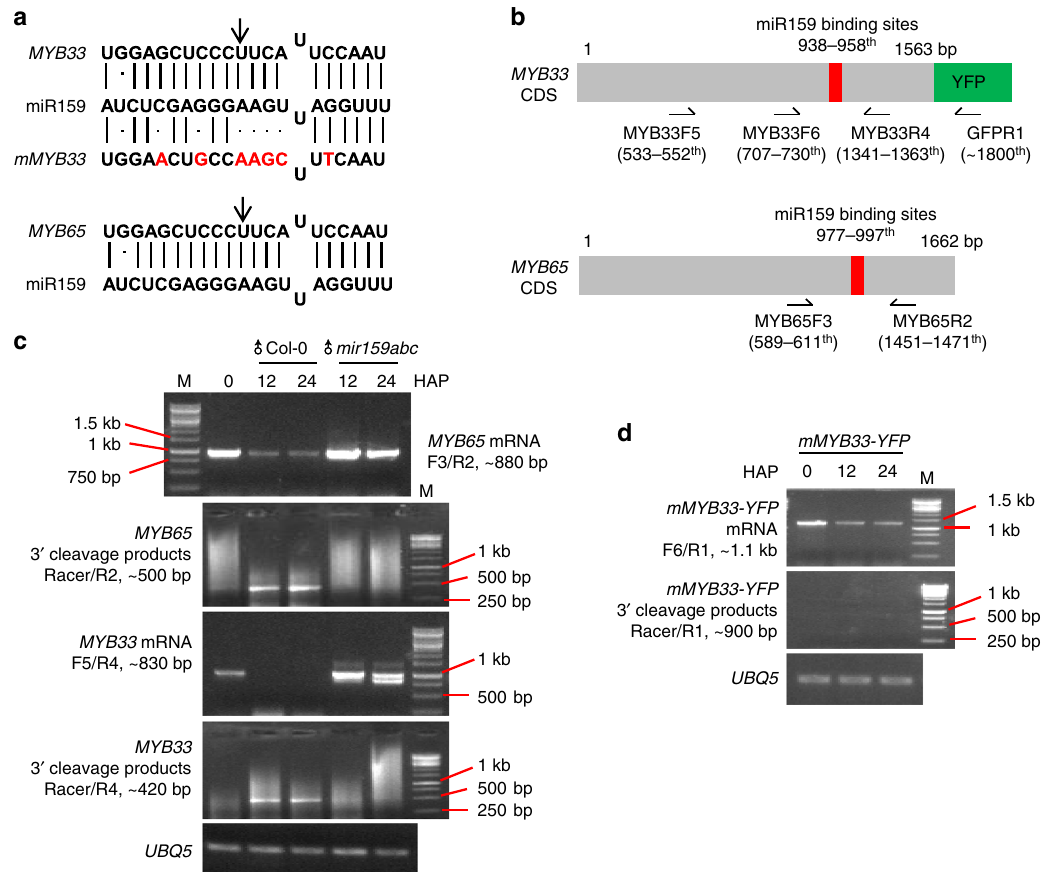
Fig. 4 Detection of 3 ′ cleavage products of MYB33 and MYB65 by 5 ′ RACE-PCR. a Alignment of miR159 and its targeting sites on MYB33 and MYB65 . Mutated nucleotides of miR159 binding sites are highlighted in red as mMYB33 . Vertical lines and dots indicate complementary nucleotides and uncomplimentary one, respectively. The arrows indicate the cleavage site of miR159 on the coding region of MYB33 or MYB65 . a Schematics of MYB33 and MYB65 coding regions, the location of miR159 binding sites, positions of primers used in c – d . Red rectangles indicate miR159 targeting sites. Arrows indicate the orientation of primers. c , d Semi-quantitative 5 ′ RACE-PCR to detect 3 ′ cleavage fragments generated through miR159-guided cleavage of MYB33 and MYB65 transcripts. UBQ5 is a loading control. M indicates the DNA ladder, and standard sizes were labeled. For c , we used pistils from Col-0, and pollinated it using pollen from Col-0 or the mir159abc triple mutant. For d , we used pistils from the proFWA::mMYB33-GFP transgenic plants, and pollinated it using pollen from Col-0. The experiments were performed with two biological replicates. Source data are provided in the accompanying Source Data fi